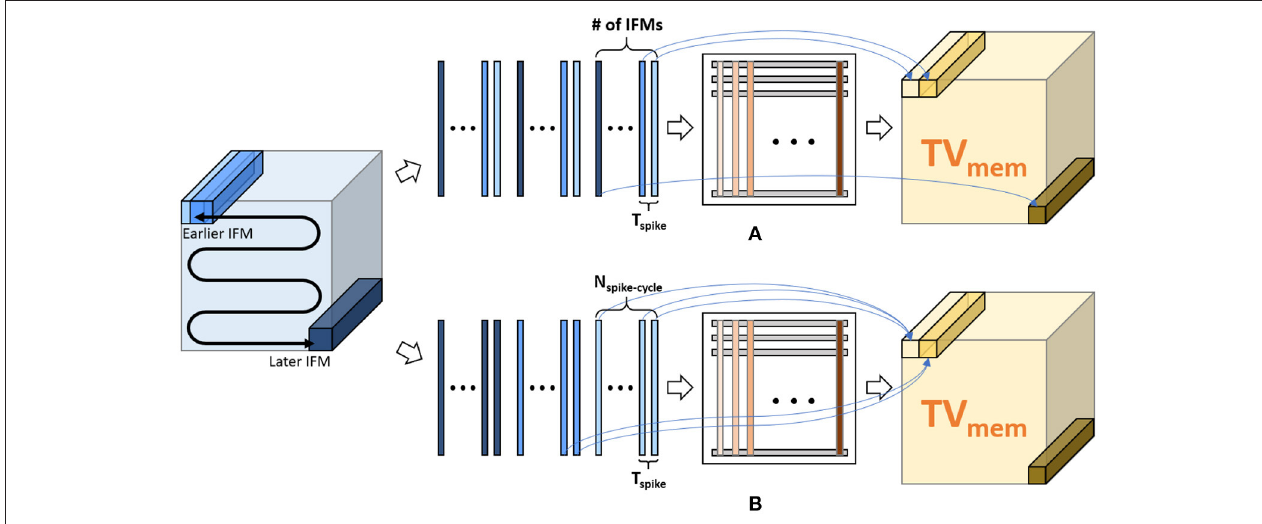
FIGURE 8 | Inference approaches: (A) sequential processing of spike cycles: serially process all input feature maps (IFMs) in a total IFM (TIFM) for a given spike cycle and generate the entire TV mem . (B) sequential processing of IFMs: an IFM is serially processed for N spike-cycle ( = T total